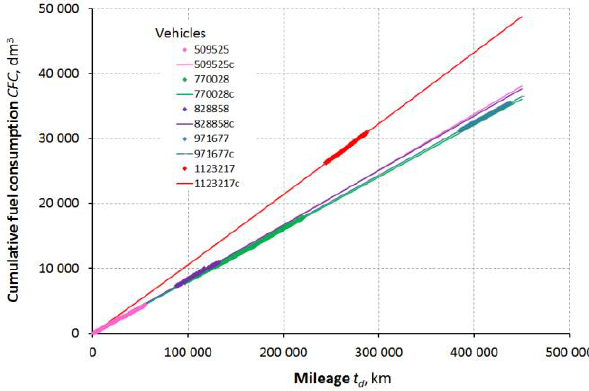
Fig. 5. Cumulative fuel consumptions of analyzed vehicles